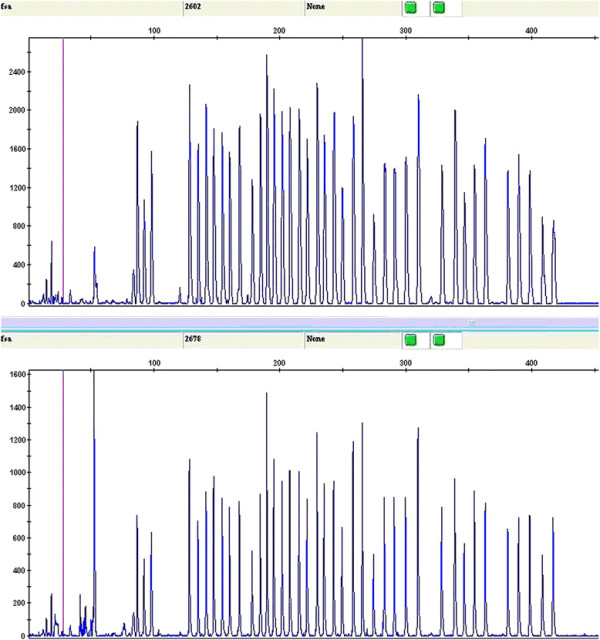
GeneMapper analysis. No significant difference was observed compared to the standard probe provided in the assay. The chart shows the results of capillary electrophoresis for one patient (upper panel) and one control subject (upper panel). There is no significant difference between the samples.